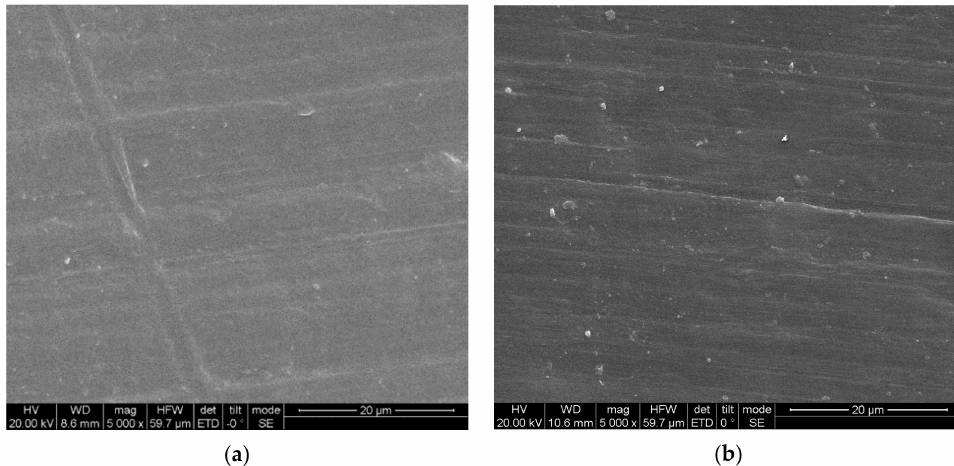
Figure 1. Scanning electron microscopy images of ( a ) HDPE and ( b ) UHMWPE.